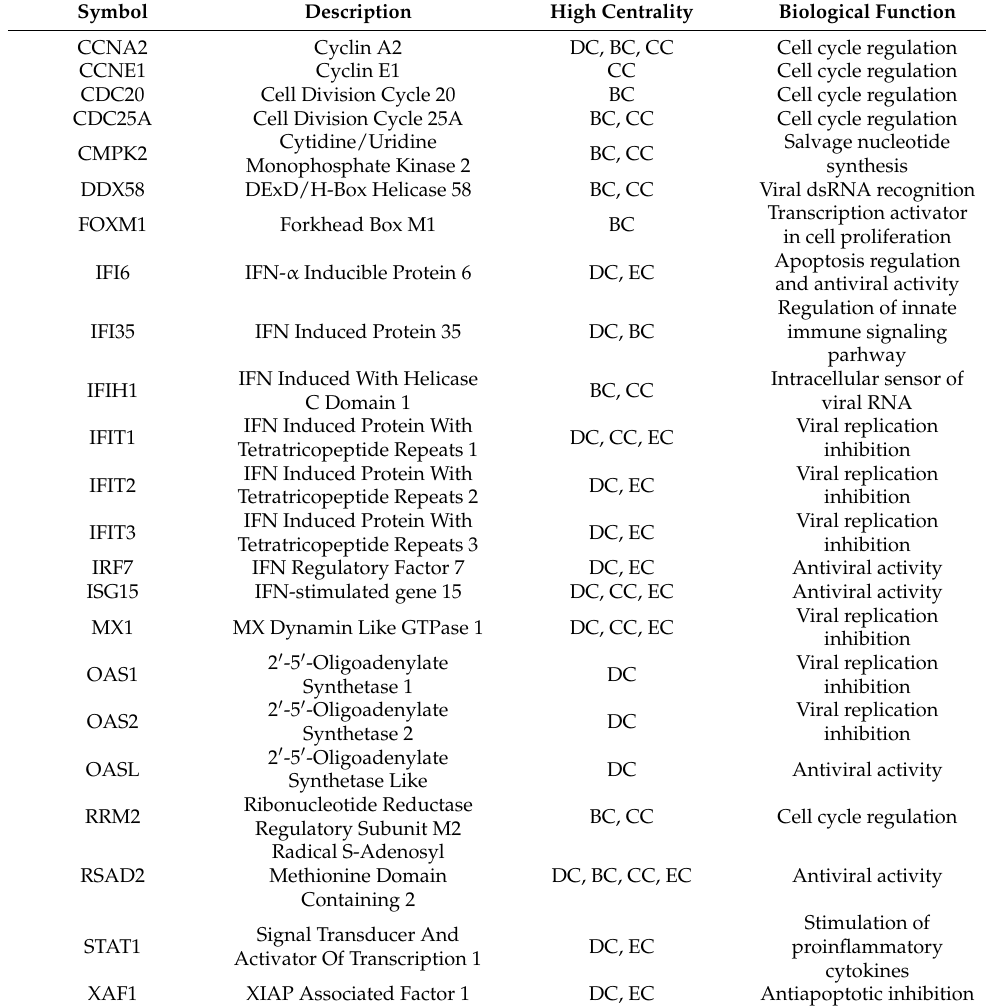
Table 3. Summary of biological function of 23 nodes with high centrality